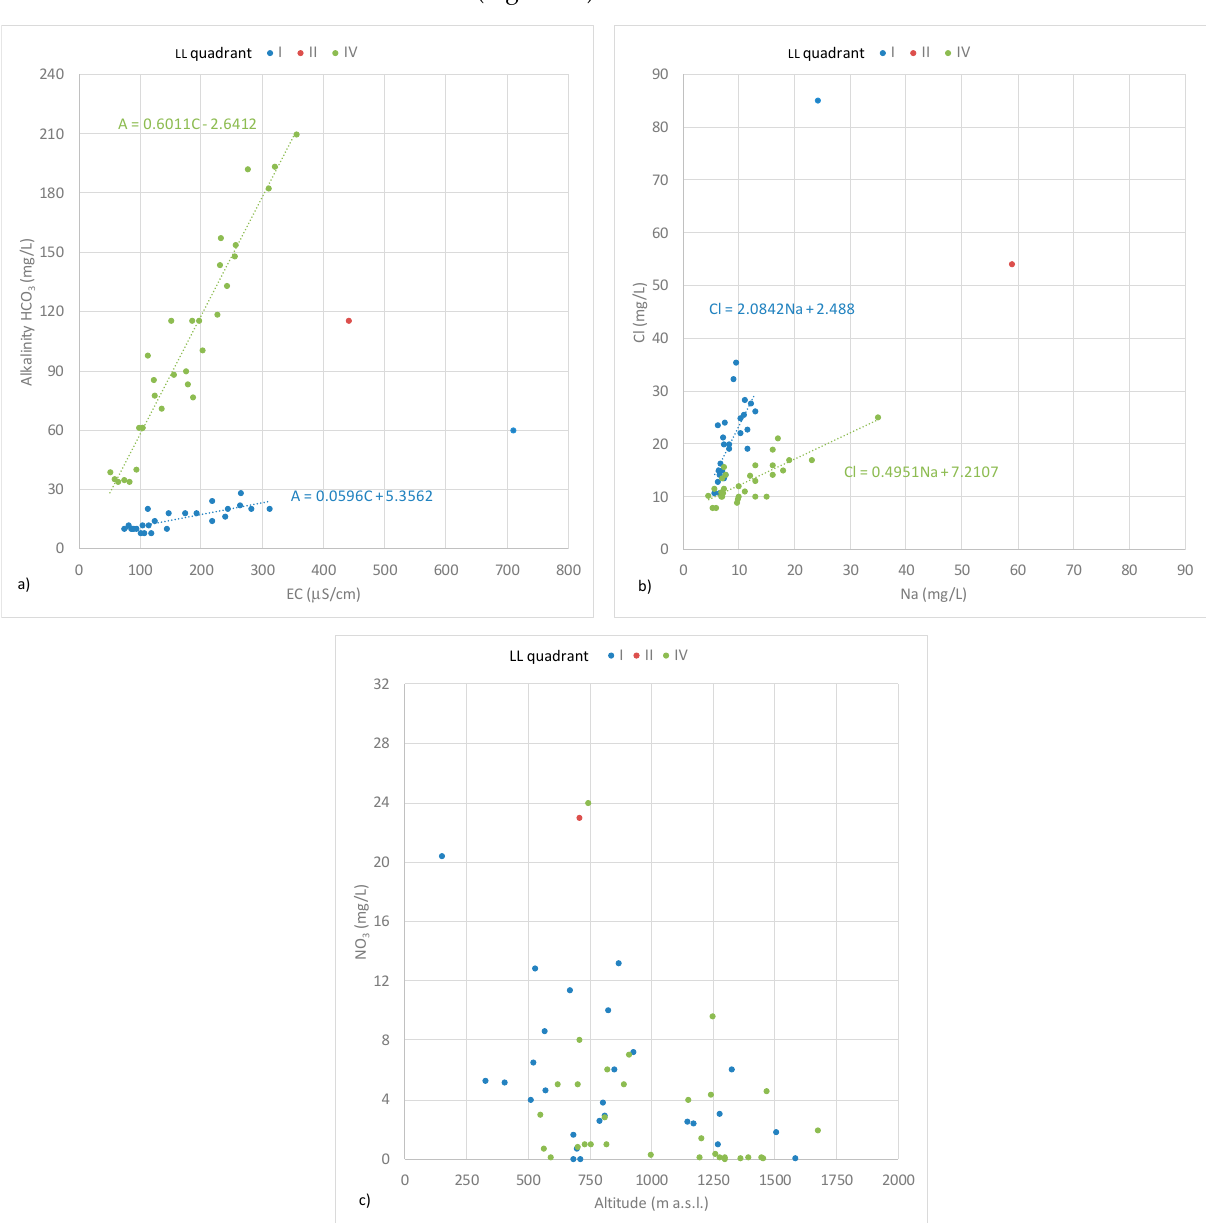
Figure 5. ( a ) Correlations between EC and A, ( b ) Na + and Cl - and ( c ) NO 3 − and altitude according to classification of water springs in LL diagram. A good correlation between chloride and sodium ions was observed (Figure 5b). Waters with alkalinity close to 40 mg/L show a change in their gradient, becoming very similar to that of the I quadrant.